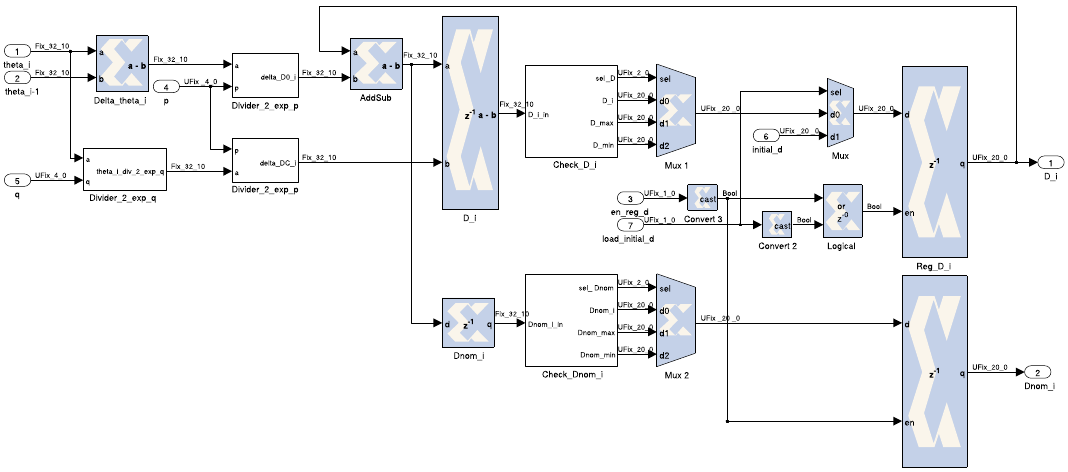
Figure 11. Clock discipline algorithm implementation details using system generator for DSP tool.